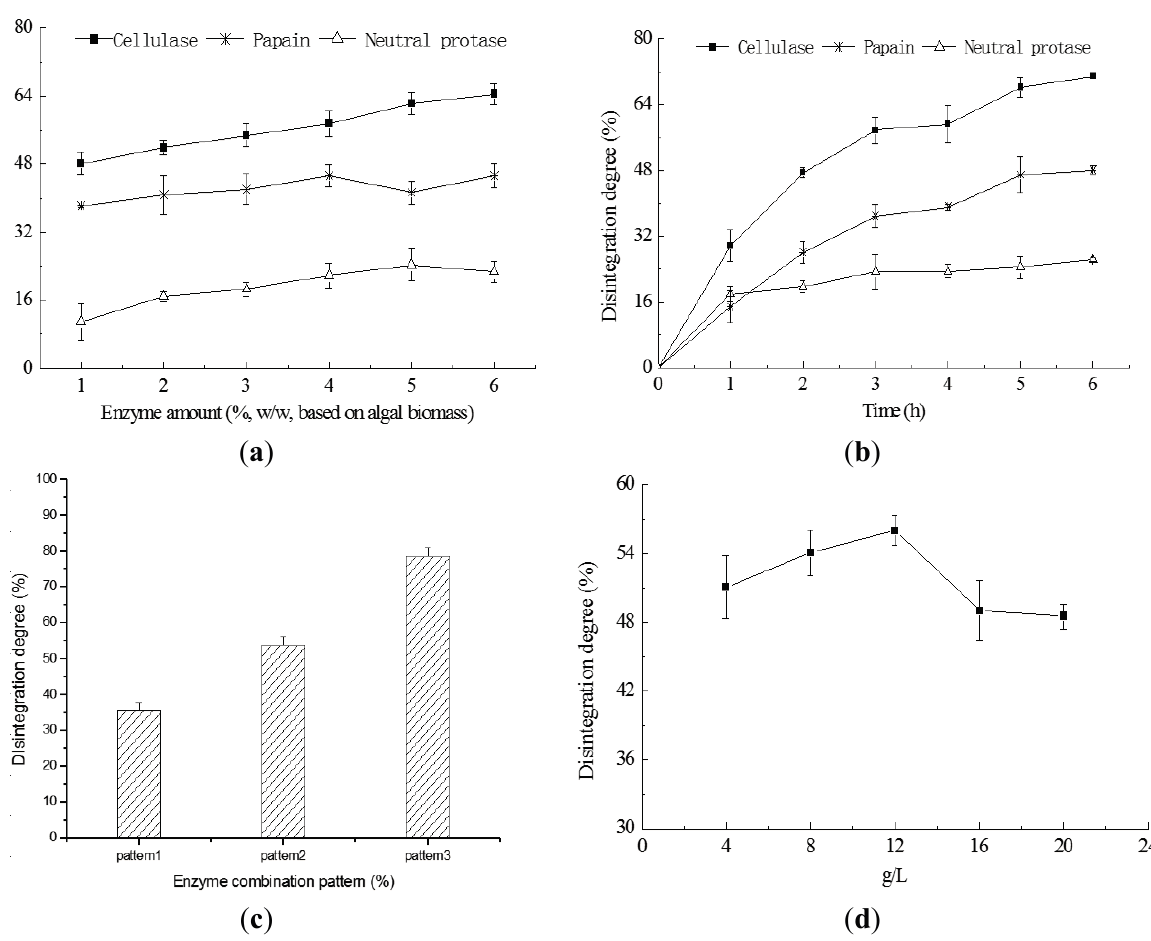
Figure 3. Effects of enzymatic treatments on the degree of cell disintegration. ( a ) The treatments performed at the optimum temperatures of the enzymes (cellulase 50 °C, papain 40 °C, respectively), with cell concentration 4 g/L and pH 6.5; ( b ) The quantity of cellulase was 5% ( w / w ), papain 3% ( w / w ) and neutral protease 3% ( w / w ), with cell concentration 4 g/L; ( c ) In pattern 1, 2% ( w / w ) papain and 3% ( w / w ) cellulase were combined; in pattern 2, 3% ( w / w ) cellulase acted for 3 h and 2% ( w / w ) papain followed, acting for 2 h; in pattern 3, the lyses was performed by 2% ( w / w ) papain for 2 h and then by 3% ( w / w ) cellulase for 3 h, with the cell concentration 20 g/L; ( d ) Treated by 2% ( w / w ) papain for 2 h and by 3% ( w / w ) cellulase for 3